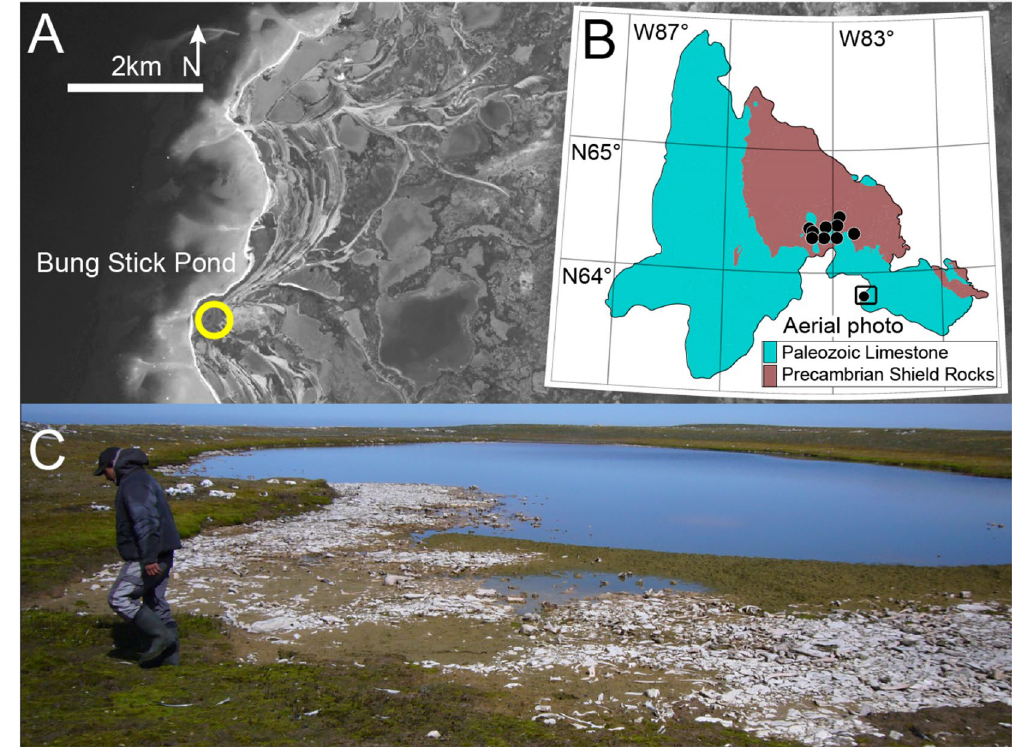
Figure 1. Bung Stick Pond and its catchment at Native Point, Southampton Island, Nunavut; ( A ) Aerial photo of Native Point (Orthoimage GéoBase, Natural Resources Canada), yellow circle—Bung Stick Pond; contains information licensed under the Open Government Licence—Canada; ( B ) Simplified geological map of Southampton Island 17 and location of nine reference lakes and ponds; (Source: Geological Survey of Canada, "A" Series Map 1404A, 1977, 1 sheet, https:// doi. org/ 10. 4095/ 108900; contains information licensed under the Open Government Licence—Canada; georeferenced with Grass GIS 7.8.3; https:// grass. osgeo. org/) ( C ) Photo of Bung Stick Pond facing northward, note scattered bones and antler fragments and partly paleozoic limestone gravel, informed consent for the publication of image has been obtained from Gabriel